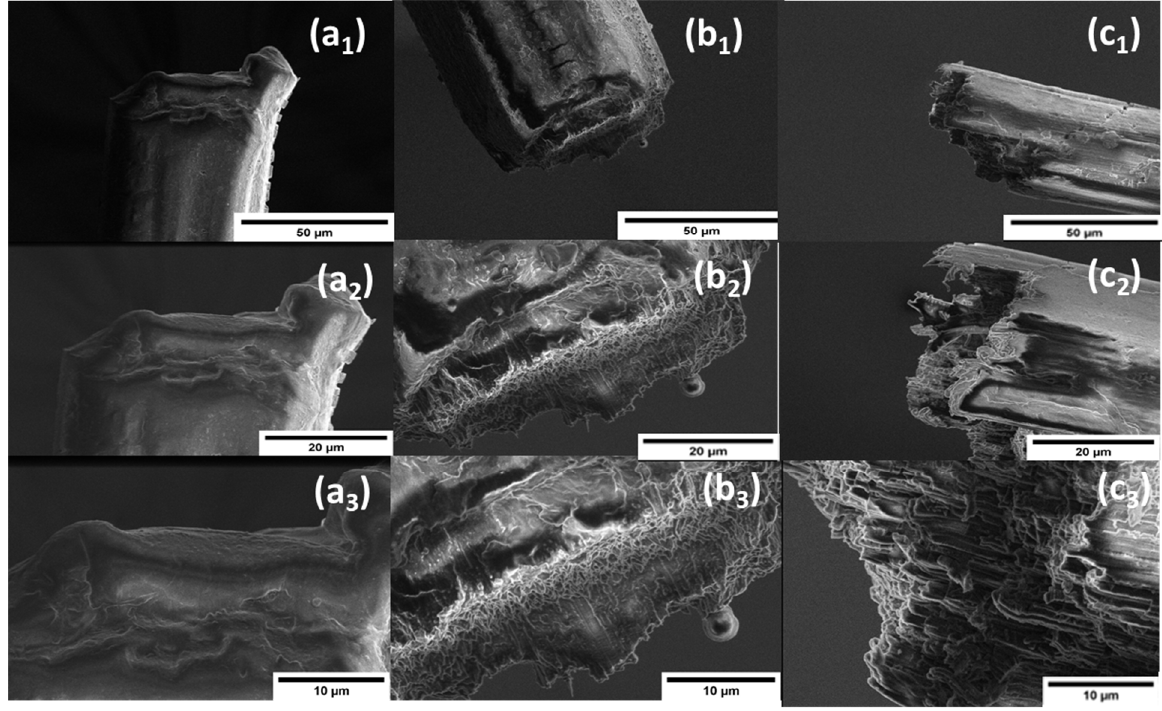
Figure 7. Fracture tips of lignin/PVA fibers: ( a ) Lig3/PVA7, ( b ) Lig5 PVA5, and ( c ) Lig7/PVA3 imaged with SEM at low (1,2) to high (3) resolution.